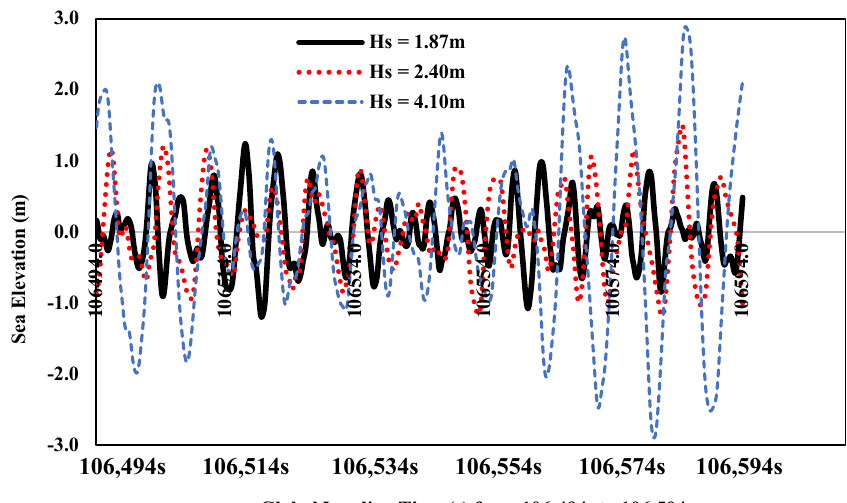
Figure 16. Wave Loading Time History for the 3 Environmental Cases.